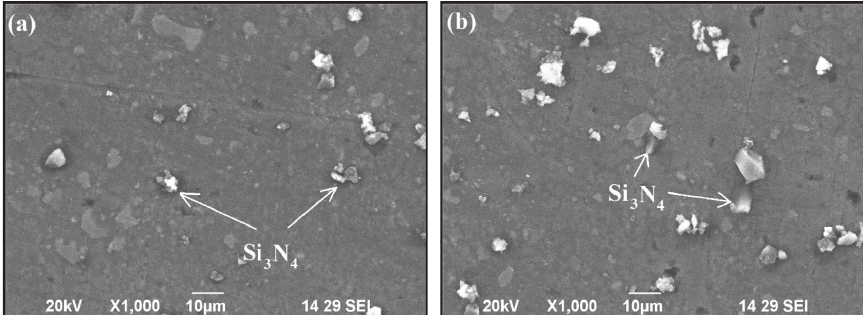
Figure 7: SEM micrograph of the (a) AA6061/15 wt.% Si